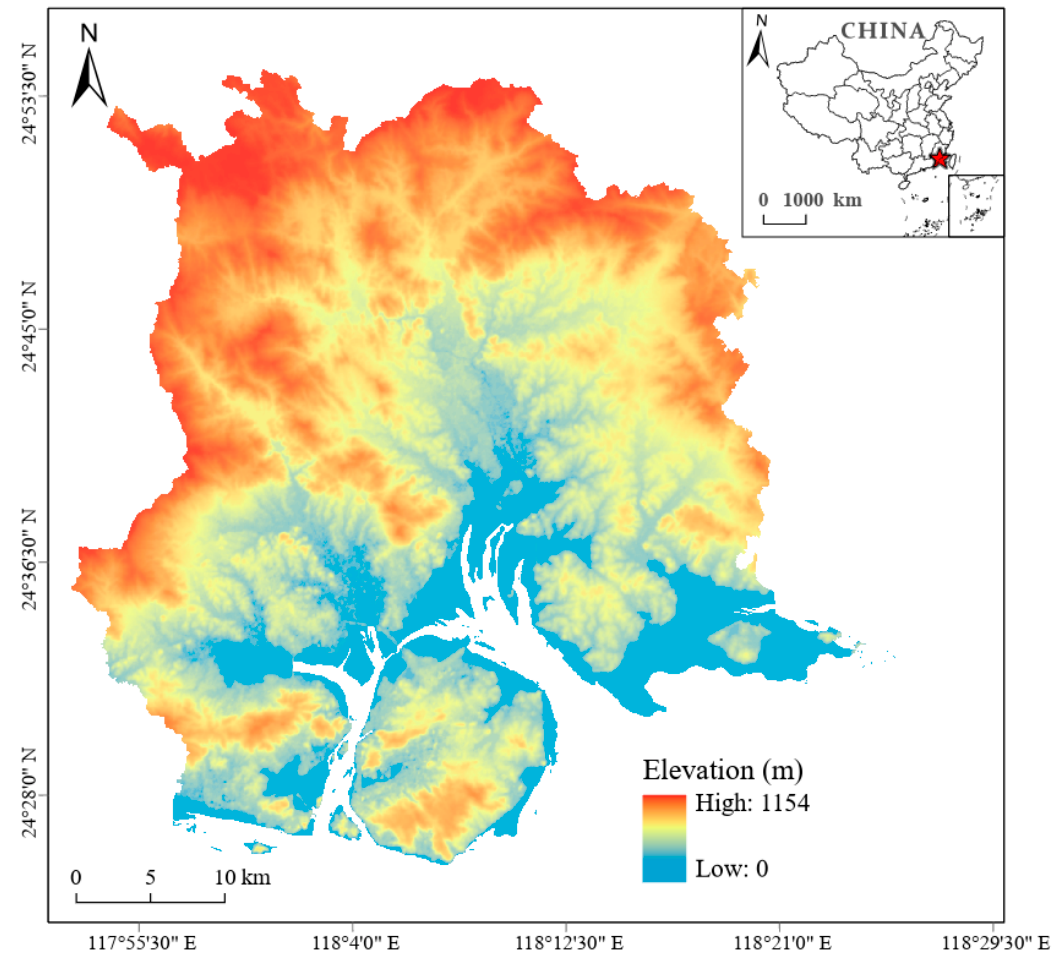
Figure 2. Maps showing the geographical location and elevation of Xiamen City.